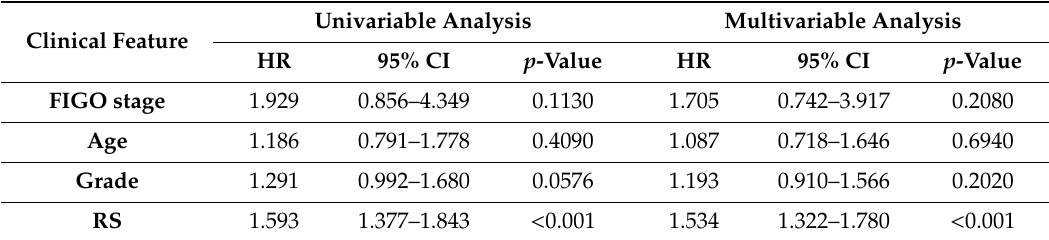
Table 2. Univariable and multivariable analysis of the TCGA cohort.